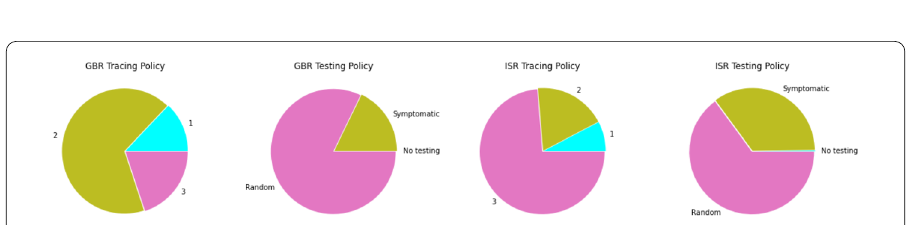
Figure 3 First group of predictors. In each subfigure, y -axis gives values in terms of population percentage for each country, and x -axis gives dates for the corresponding data. Left: number of performed tests for a day. Right: cumulative count of administered vaccines